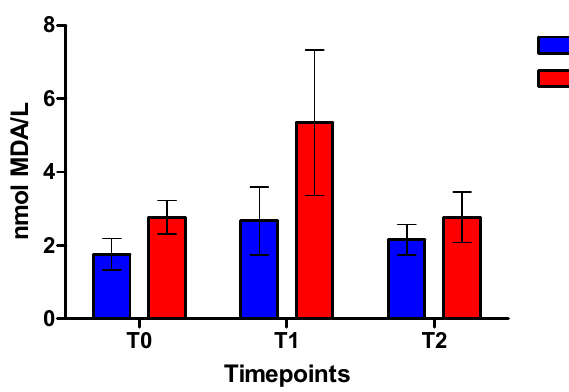
FIGURE 2 - Thiobarbituric acid-reactive substances levels (micromoles of Malondialdehyde per liter of fresh plasma) in children anesthetized with Propofol (GP) or Sevoflurane (GS). Bars represent mean±SD GP (blue bars) and GS (red bars) groups at T0, after radial artery cannulation, T1, 30 minutes after cardiopulmonary bypass launch and T2, at the end of the surgical procedure. Values in T0, T1 and T2 timepoints are not significantly different in each group by Friedman´s test. GS is not different from GP group by Wilcoxon test.